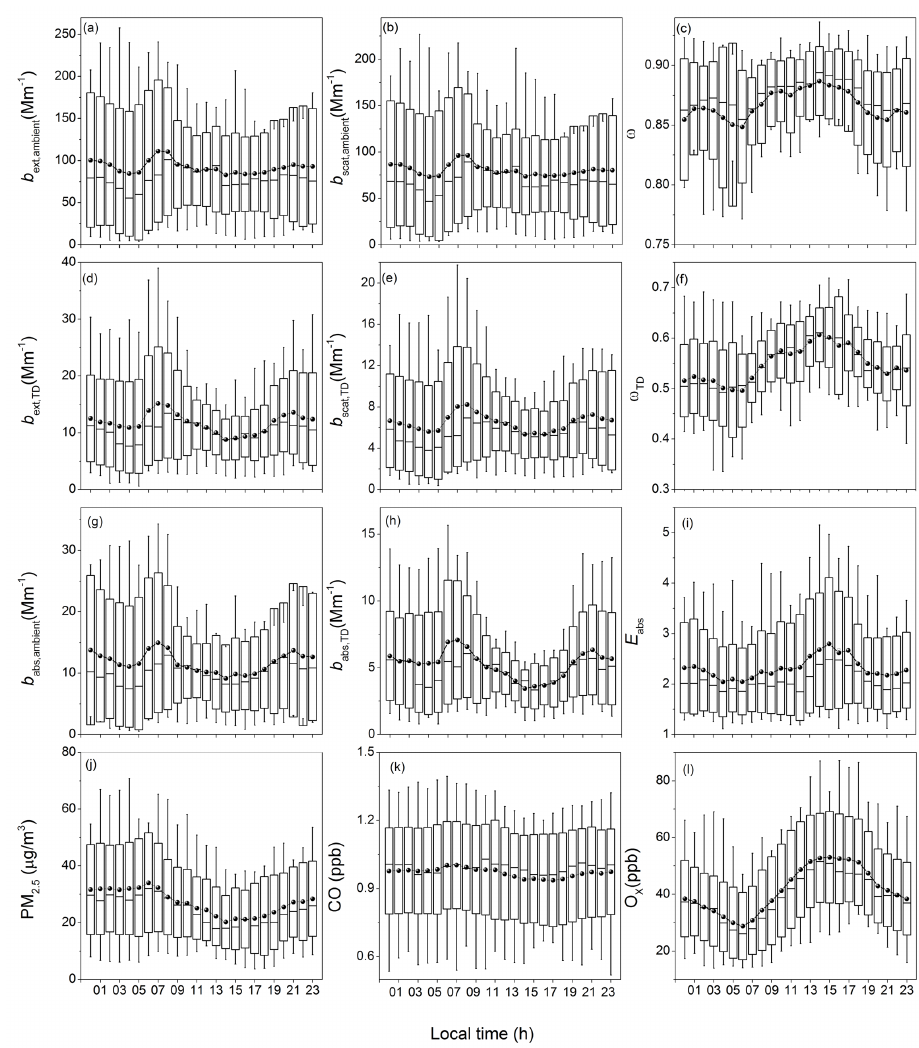
Figure 5. The observed diurnal variation in aerosol optical parameters (extinction ( b ext ), scattering ( b scatt ), absorption ( b abs ) coefficients, and SSA ( ω )) of ambient particles ( b ambient , a–c , g ) and particles passed through the thermodenuder at 300 ◦ C after correcting for particle losses ( b TD , d–f , h ). The absorption enhancement ( E abs , i ) was calculated as the ratio between b abs , ambient /b abs , TD . The mass concentrations of PM 2 . 5 (j) and the mixing ratios of CO (k) and O x (l) are also shown for assessing the effect of photochemical oxidation. The optical measurement at λ = 532nm covered the period 16 June to 23 July 2016. The box and whisker plots show the mean (dots), median (centre solid line), lower and upper quartile (boxes), and 5th and 95th percentile